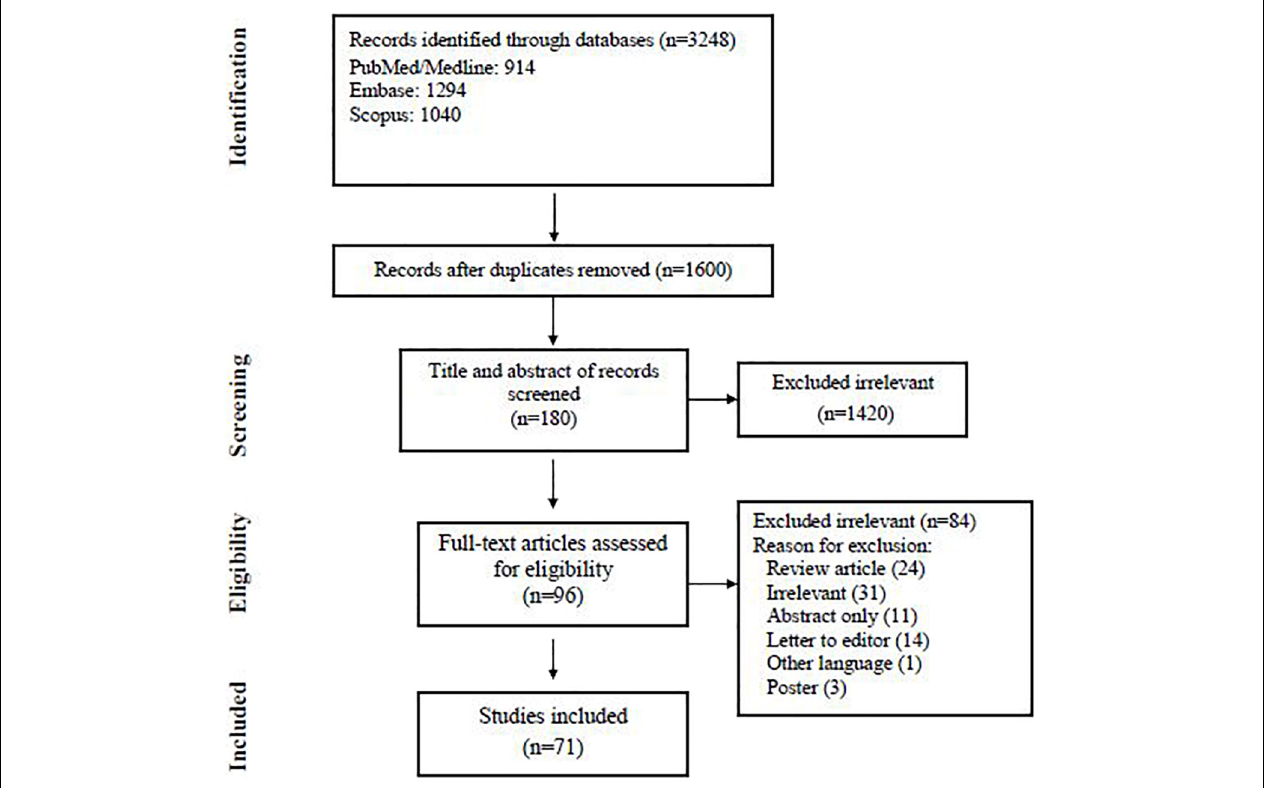
FIGURE 1 | Flowchart of study selection for inclusion in the systematic review and